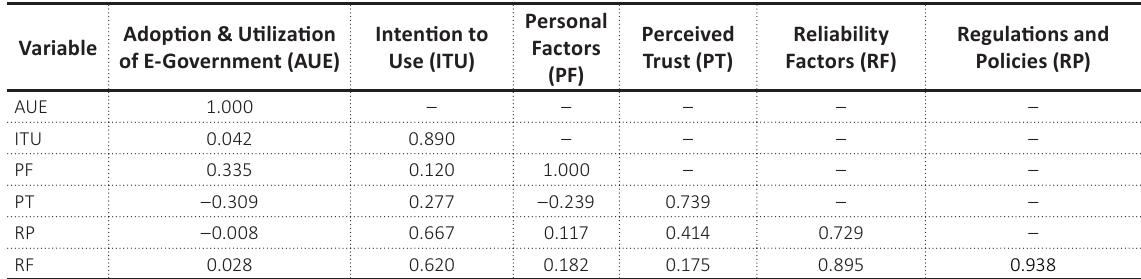
Table 4. Fornell-Larcker criterion of discriminant